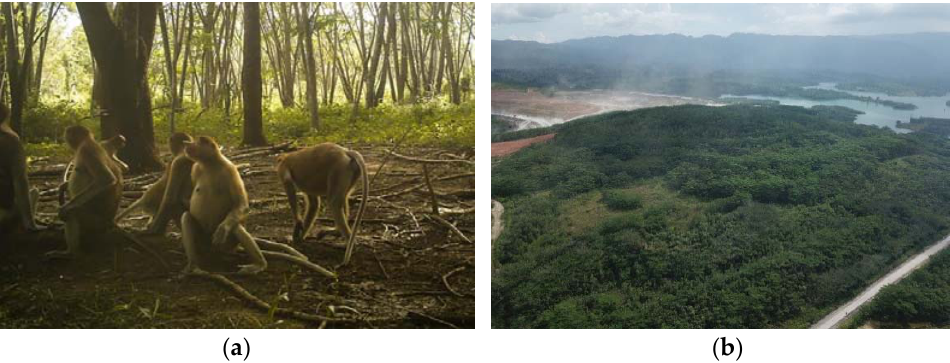
Figure 10. ( a ) Bekantan ( Nasalis larvatus ) in ( b ) rehabilitated post-coal-mining sites that was later converted into an arboretum in Penajam Paser Utara, East Kalimantan, Indonesia; Photo by Yaya Rayadin.